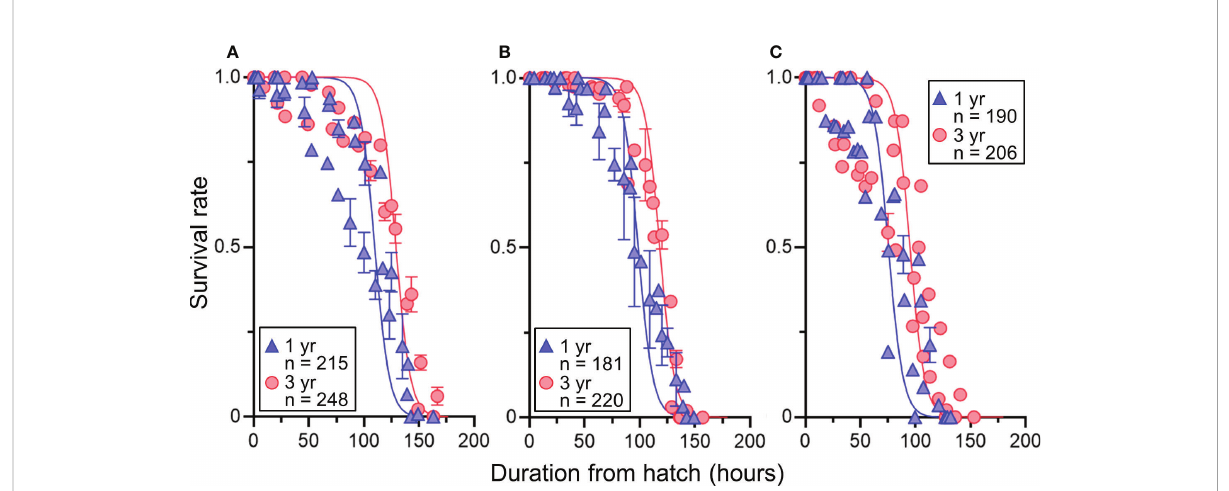
FIGURE 6 Effects of maternal age (1 or 3 years) on the relationship between survival rate and duration from hatching of chub mackerel larvae at different temperature treatments ( A = 18°C, B = 20°C, C = 22°C). Predicted lines using the generalized mixed effect models fi tted to the observed data are shown. Data are shown as mean ± SE. Numbers indicate sample sizes.